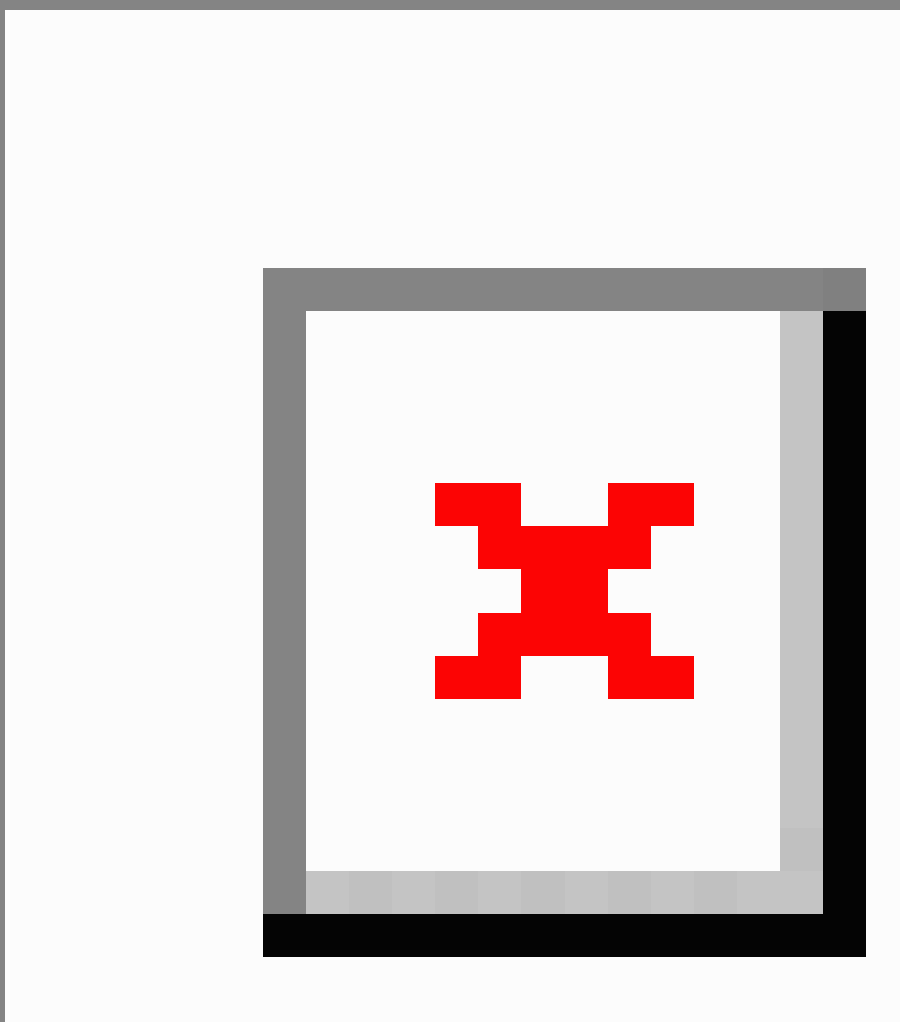
Figure 2. Risk of bias analysis of each included